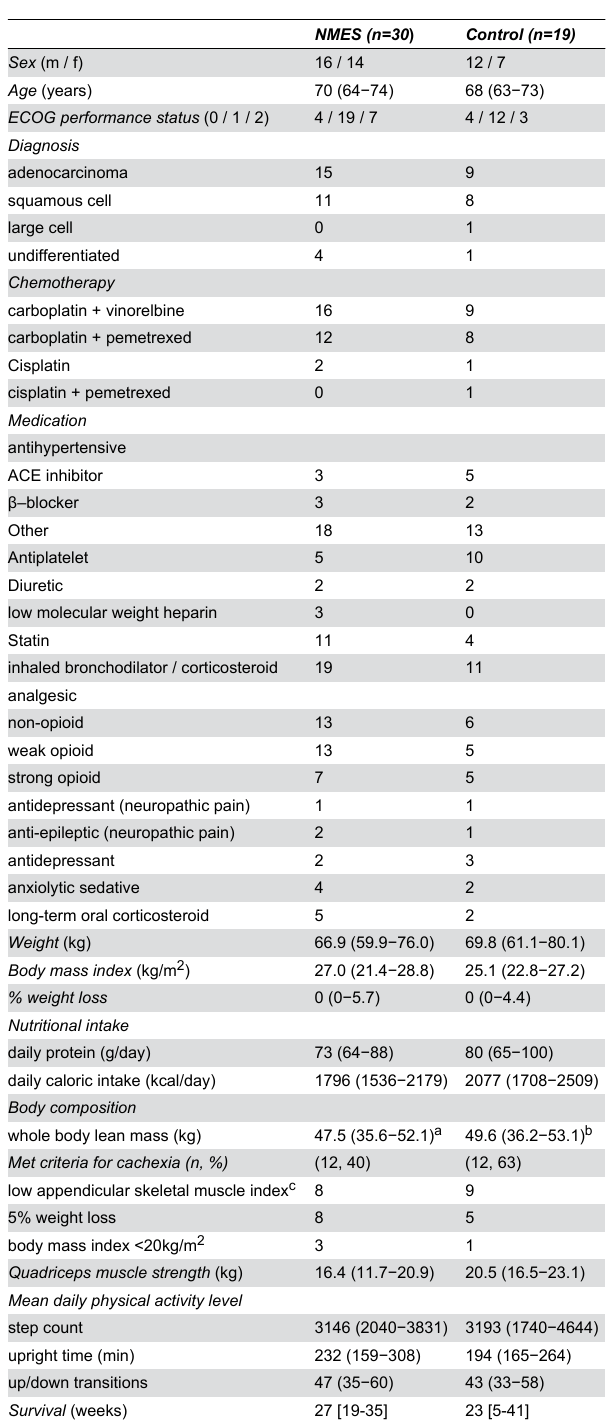
Table 1. Patient